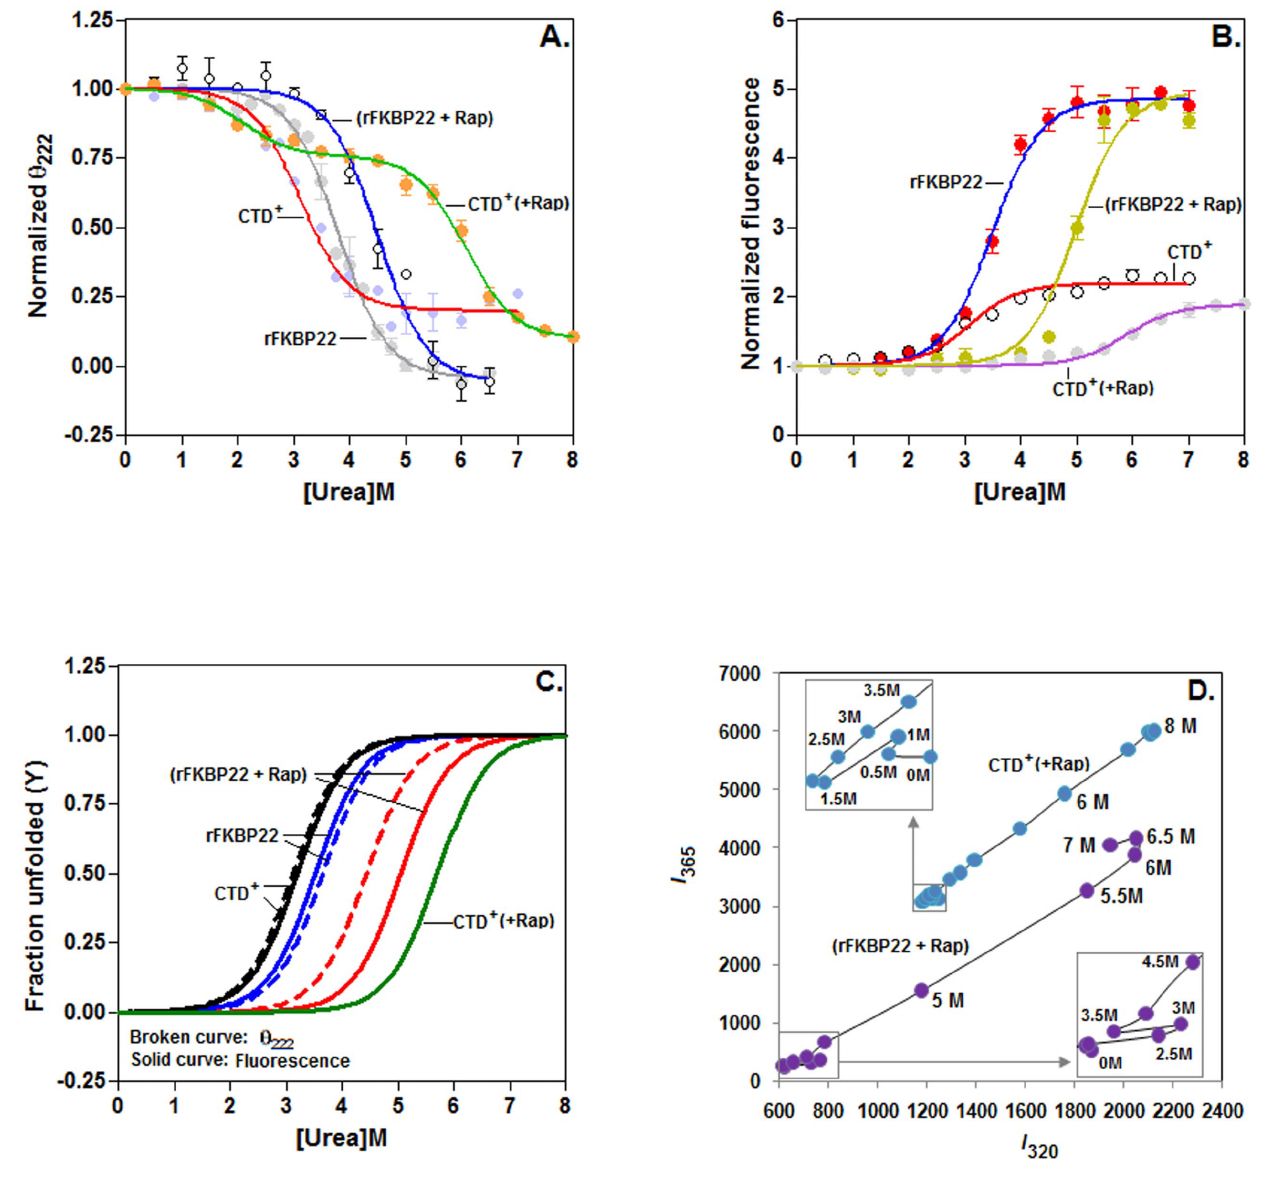
Figure 2. Unfolding of rFKBP22 and CTD + (bound or unbound with rapamycin) by urea. (A) The h 222 (ellipticity at 222 nm) values, extracted from the CD spectra (Figures S4A–4D) of the indicated proteins (saturated with or without rapamycin) at 0–7/8 M urea, were normalized and plotted as described [12]. (B) The Trp fluorescence intensities at 330 nm (for rFKBP22 or rapamycin-bound rFKBP22) and at 347 nm (for CTD + or rapamycin-saturated CTD + ) were similarly derived from the fluorescence spectra (Figures S4E-4H), normalized and plotted against the matching urea concentrations. All lines through the fluorescence or ellipticity values represent the best-fit curves. (C) Mechanism of urea-induced unfolding. Fraction of denatured protein molecules ( Y ) in the absence and presence of rapamycin were determined from the h 222 or Trp fluorescence intensity values (collected as stated above) using equation 2 and plotted against the relevant urea concentrations values as explained in Materials and methods. (D) Phase diagrams show the denaturation of rapamycin-equilibrated rFKBP22 or CTD + at 0–7/8 M urea. I 320 and I 365 indicate the fluorescence intensity values (obtained from Figures S4E–4H) of the indicated proteins at 320 nm and at 365 nm, respectively. Inset boxes show the enlarged view of the fluorescence data at 0–3.5/4.5 M